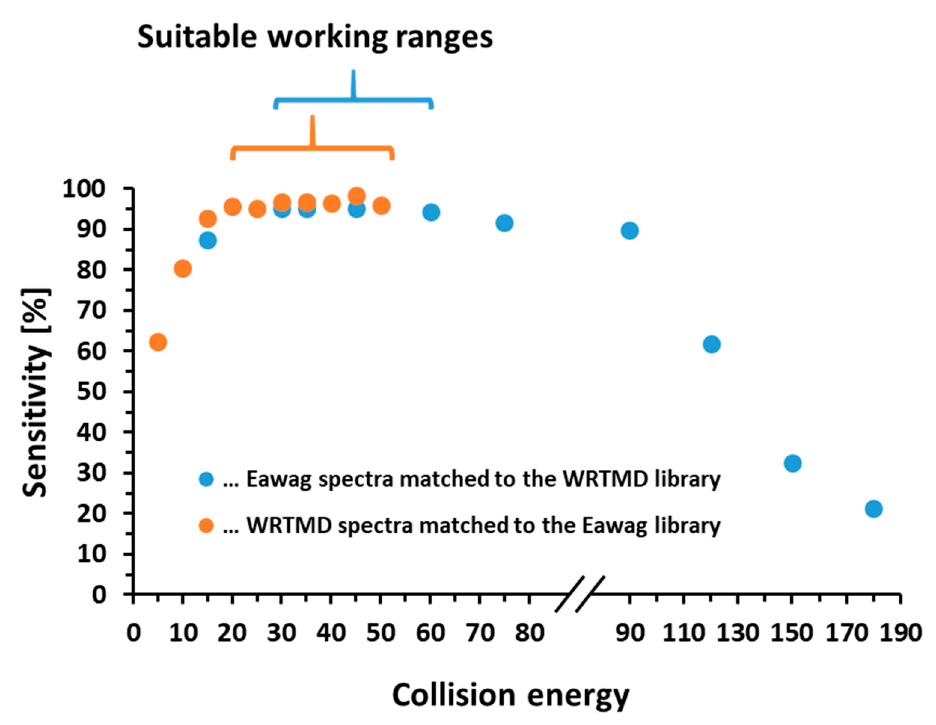
Figure 1. Evaluation of the reliability of a match in the WRTMD and the Eawag library illustrated by plots of sensitivity vs. collision energy applied during spectra acquisition.